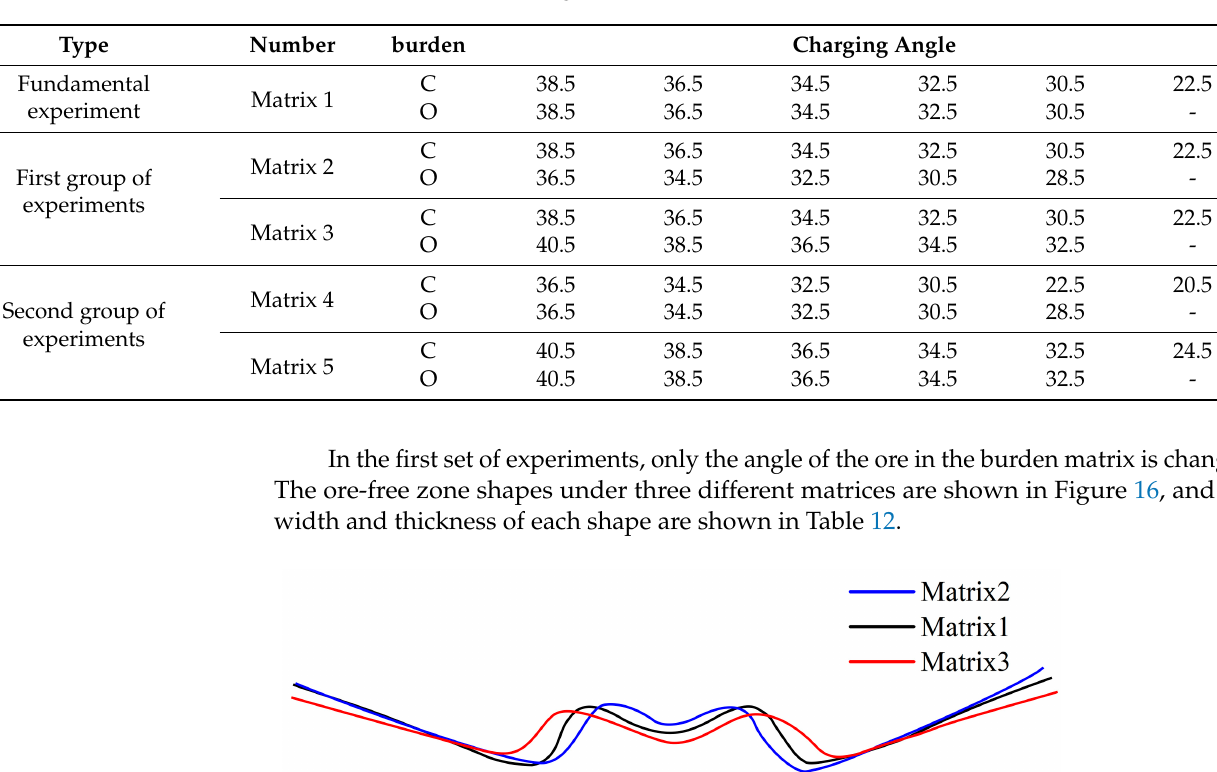
Table 11. Burden matrix design scheme.